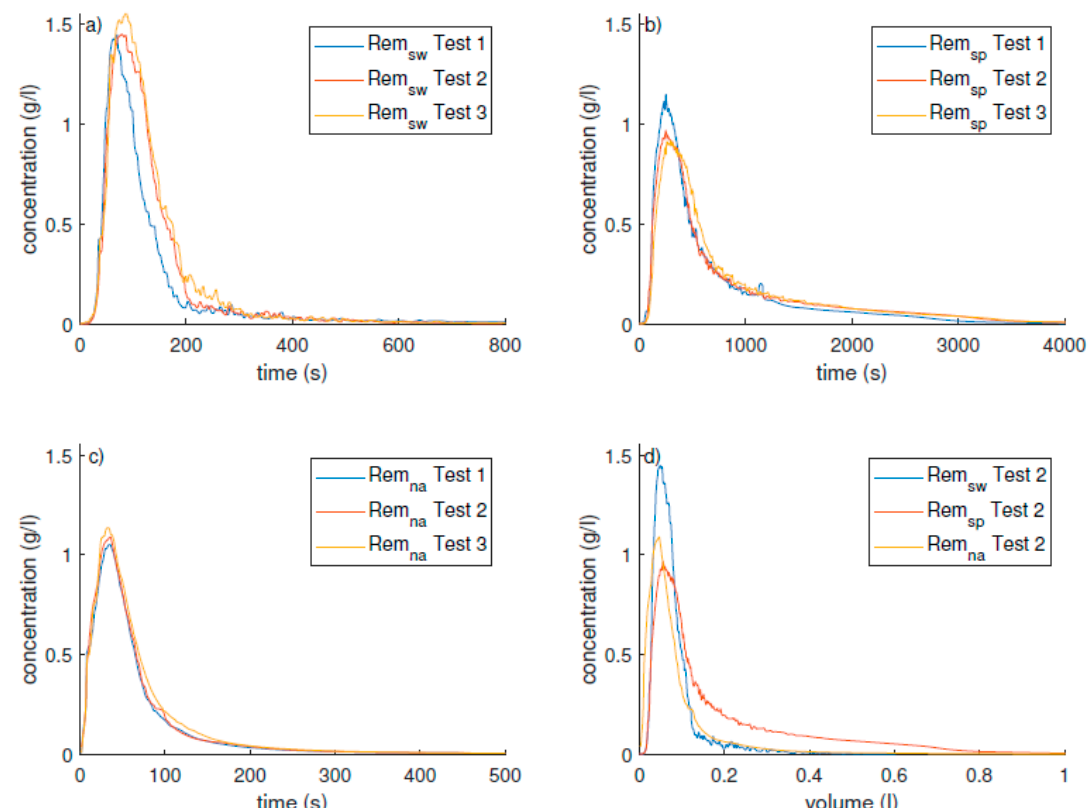
Figure 5. Breakthrough curves (BTCs) from sawed ( a ), split ( b ) and natural ( c ) fractured specimens; ( d ) shows a comparison of the BTCs of all three different fracture types.